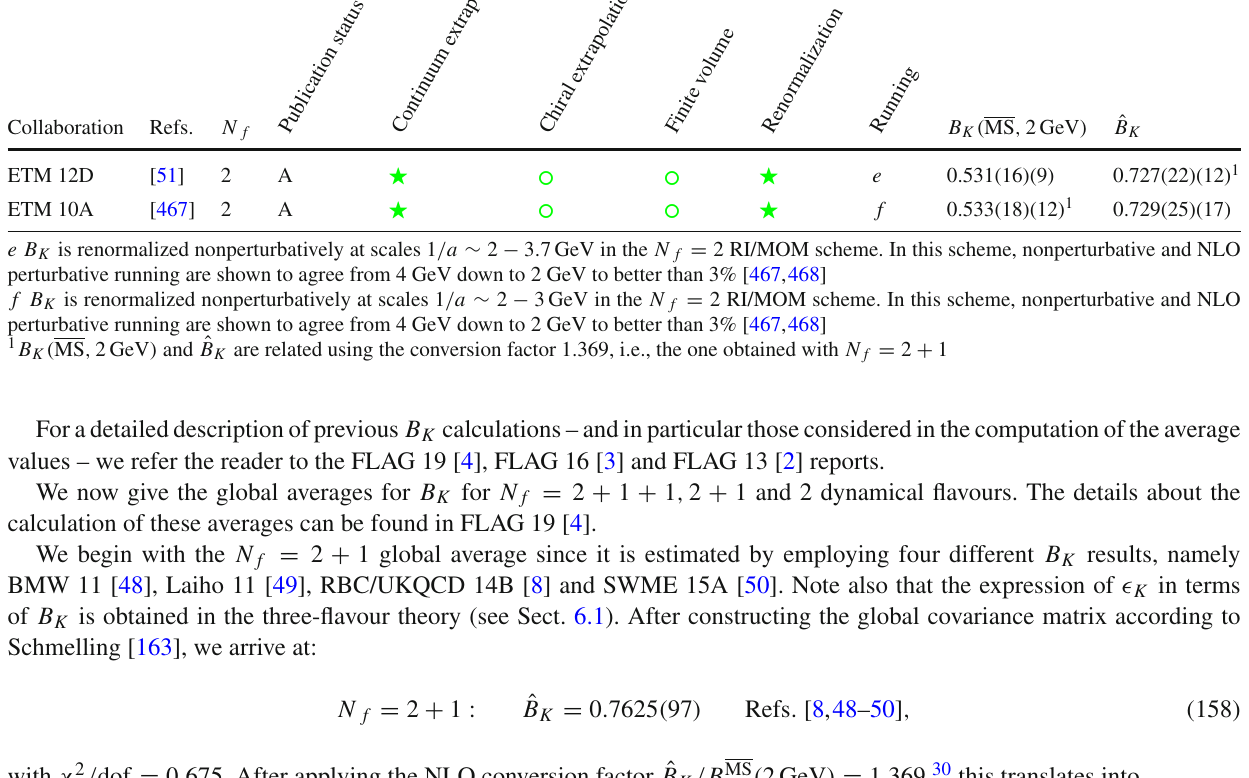
Table 32 Results for the kaon B -parameter in QCD with N f = 2 dynamical flavours, together with a summary of systematic errors. Information about nonperturbative running is indicated in the column “running”, with details given at the bottom of the table